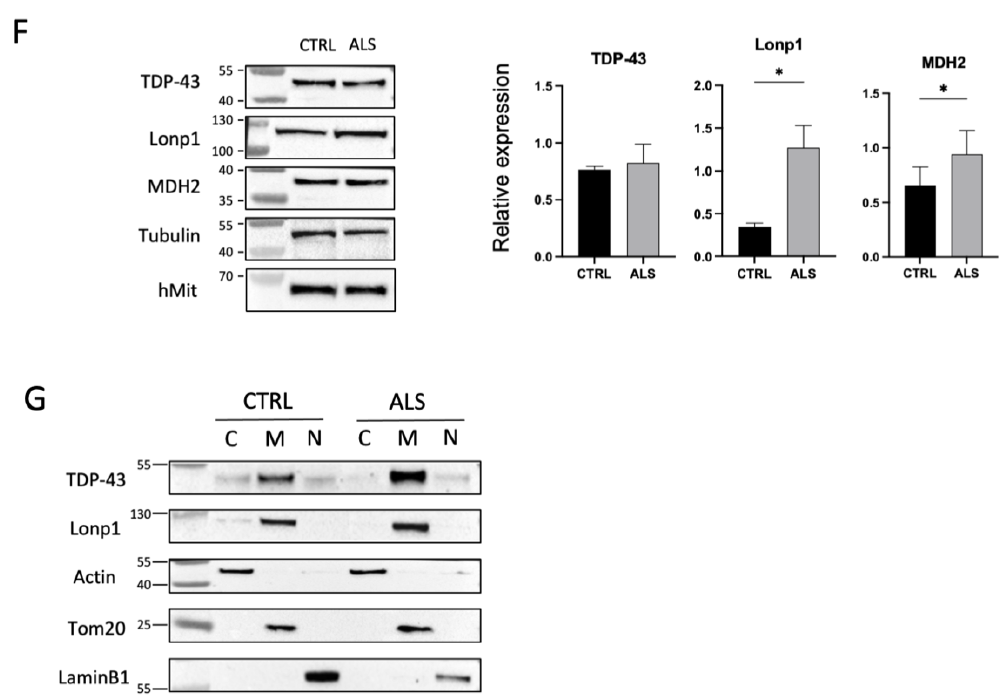
Figure 2. ( A ) Volcano plot of data from label-free quantification of proteins identified with at least two unique peptides (924 proteins) in amyotrophic lateral sclerosis (ALS) and control (CTRL) fibroblasts. Red and blue dots represent up- and down-regulated proteins with a log 2 fold change ± 0.58 and p -value cut-off <0.05. ( B ) Extracellular and/or subcellular localization of differentially expressed proteins (DEPs). ( C ) List of differentially expressed proteins in ALS and CTRL fibroblasts. ( D,E ) Pathway enrichment analyses of up- and down-regulated DEPs, respectively. The 20 most significantly enriched pathways and biological processes in the proteomic data of DEPs were identified by Metascape. Enriched terms are colored by p-values. The x-axis shows the value of − log10(P). ( F ) Immunoblots showing the relative expression of TDP-43 and Lonp1 in CTRL and ALS fibroblasts data are reported as mean ± SEM of three independent blots. Values are the mean ± SEM of 3 independent experiments performed on fibroblasts from two CTRL subjects and the ALS proband * p < 0.05. ( G ) Immunoblots showing the intracellular distribution of TDP-43 and LONP1 in cytosolic (C), mitochondrial (M) and nuclear (N) fractions of CTRL and ALS fibroblasts. TOM-20 and LaminB1 show the purity of mitochondrial and nuclear fractions, respectively.